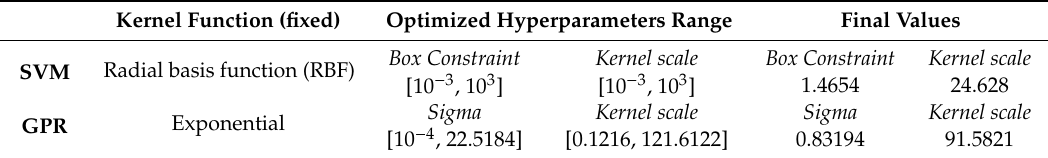
Table 1. Hyperparameter range considered for each classifier and the used final values.